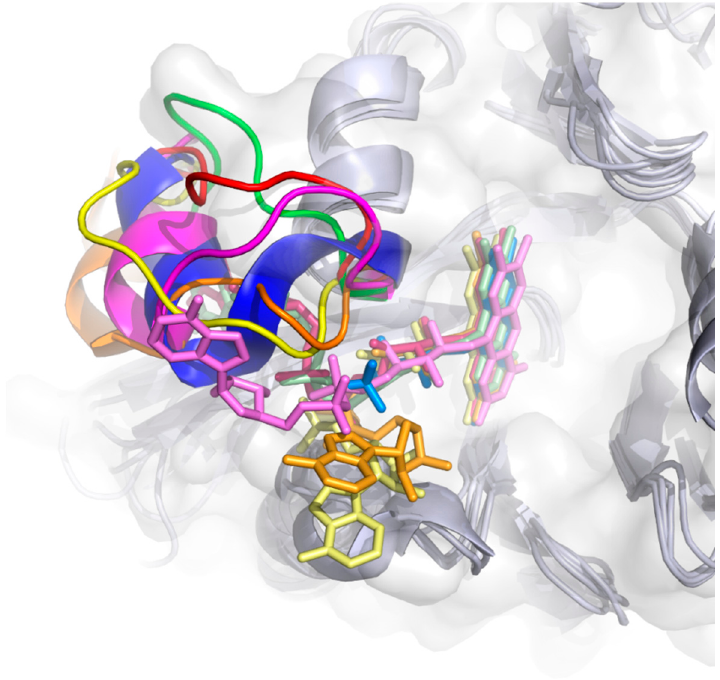
Figure 10. Zoom on the disordered loop region of two-component flavin:NADH reductases. The protein backbone is of the reductases shaded in blue/white. The loop region is illustrated according to PheA2 (PDB ID: 1RZ1, red), HpaC (2ED4, green), HpaC (2D37, blue), SMOB (4F07, yellow), BorF (5CHO, orange), and CobR (4IRA, magenta). Respective flavin ligands are shaded in pale tints.